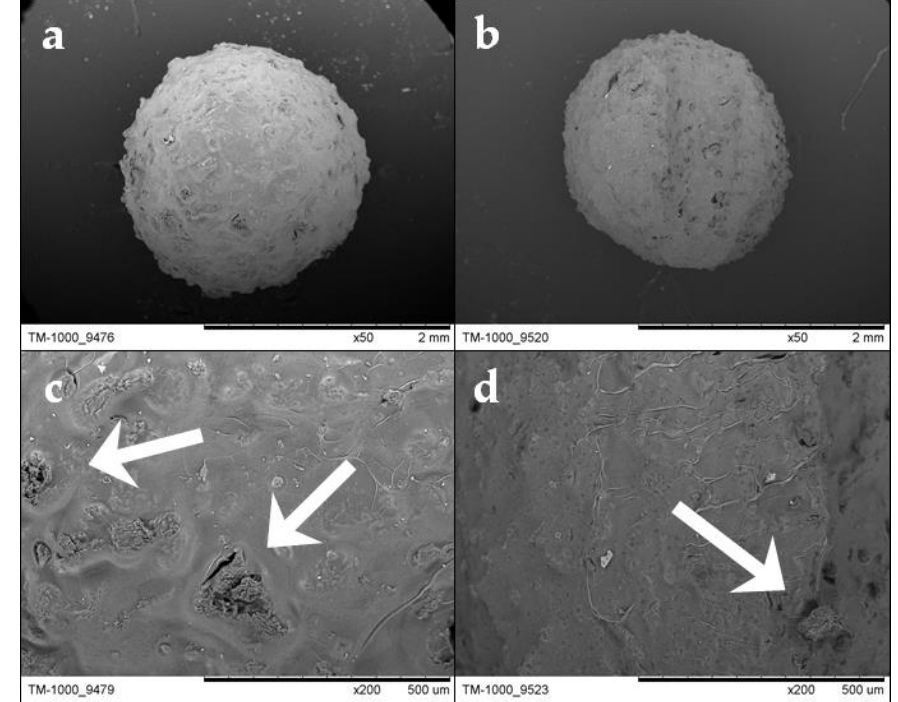
Figure 4. Image of an Alg-ChS bead ( a ) and an Alg-Ch bead ( b ) obtained with the scanning electron microscope (SEM) using 50 × magnification. At 200 × magnification, surfaces of the beads are shown, where particles of ChS ( c ) and Ch ( d ) are signaled with white arrows.